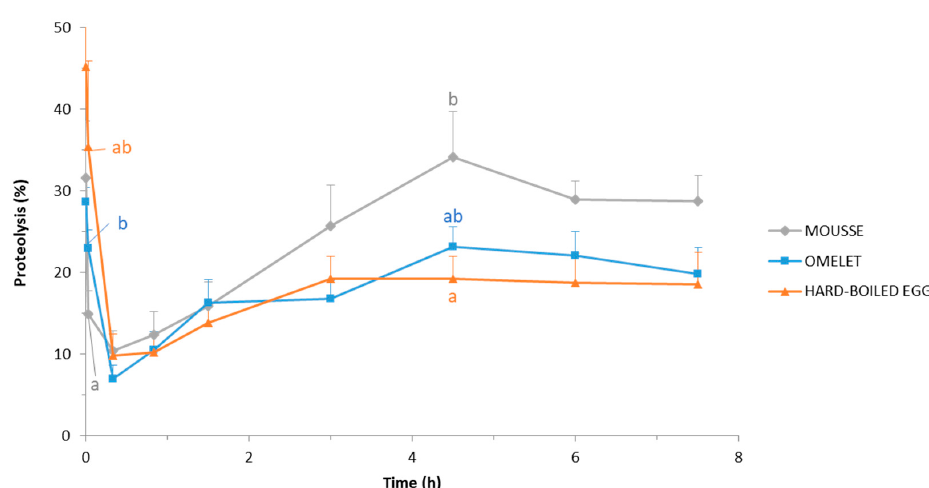
Figure 4. Degree of proteolysis (%) in the duodenal effluents throughout 7.5 h postprandial after the ingestion of the DHA-enriched omelet, hard-boiled egg, and mousse. Means and SEM were calculated from n = 9 pigs. For a given digestion time, different letters display significantly different mean values ( p < 0.05).